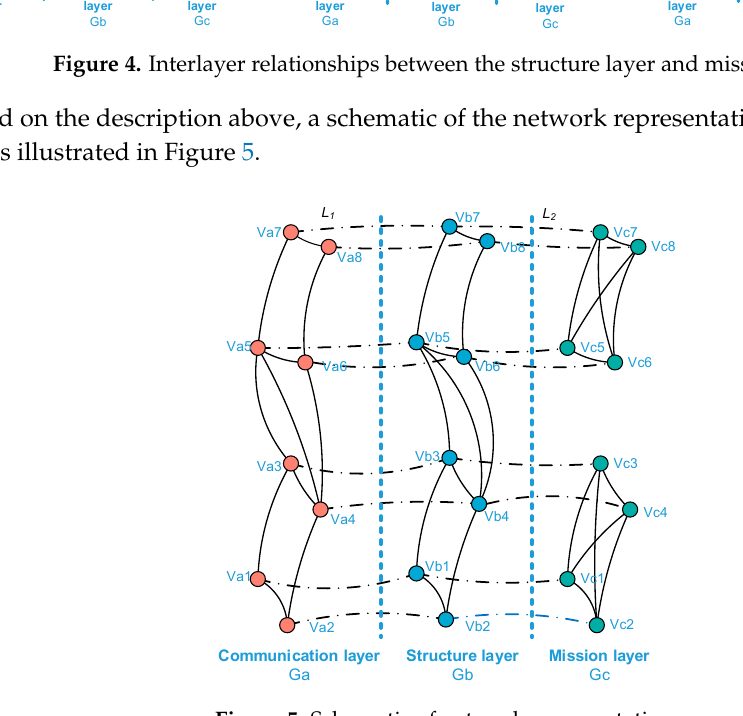
Figure 5. Schematic of network representation.